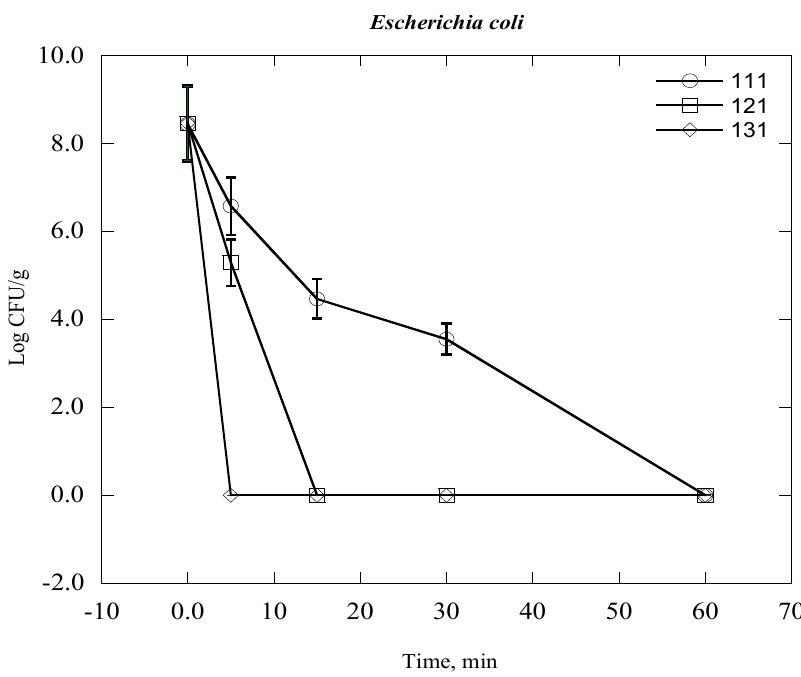
Figure 1. Inactivation of E. coli in clinical solid waste using steam sterilization. Experimental conditions: (○), 111 °C (8 psi); (□), 121 °C (15 psi) and (◊), 131 °C (27 psi).